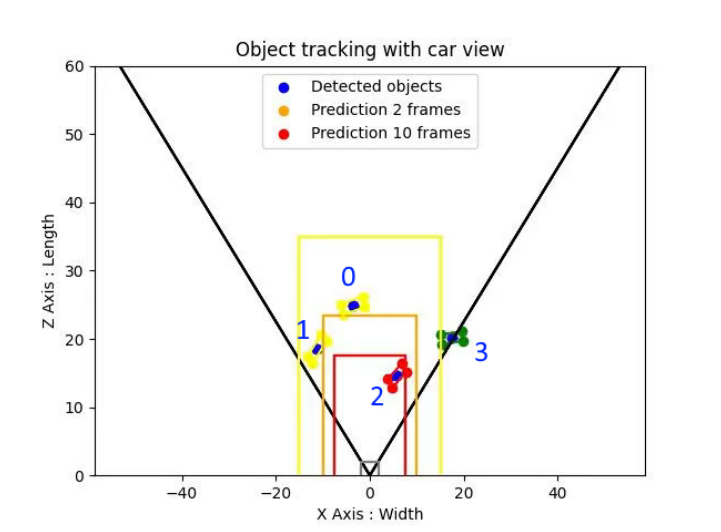
Figure 2. Visualization of 2D object tracking and predicted object trajectories. The numbers corre- spond to the tracking number of the detected vehicles, while their color corresponds to the position of the vehicles.